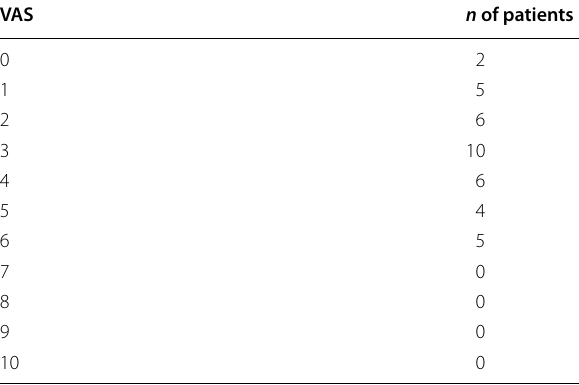
Table 2 Pain on admission according visual analogue